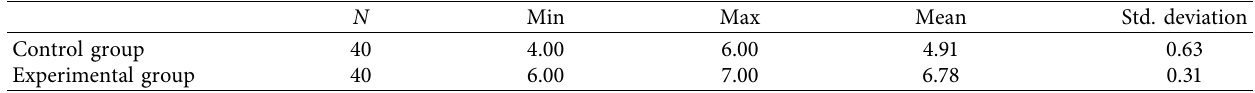
Table 3: Descriptive statistics for the posttests.